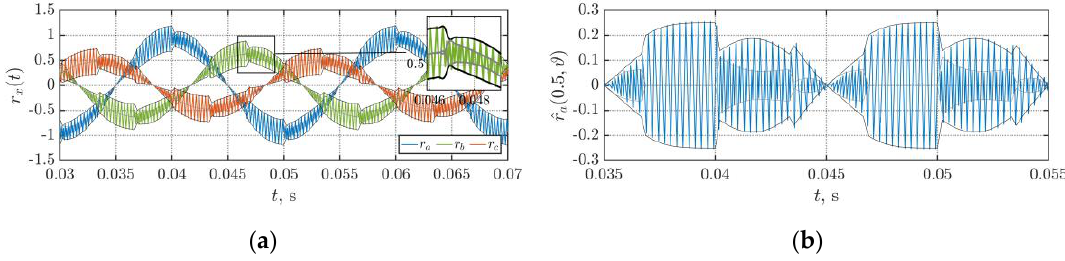
Figure 12. Primary (black) and secondary (gray) envelopes in case of DPWM0 at m = 0.5 and f sw = 3.6 kHz: ( a ) Normalized phase currents; ( b ) Normalized phase current ripple.